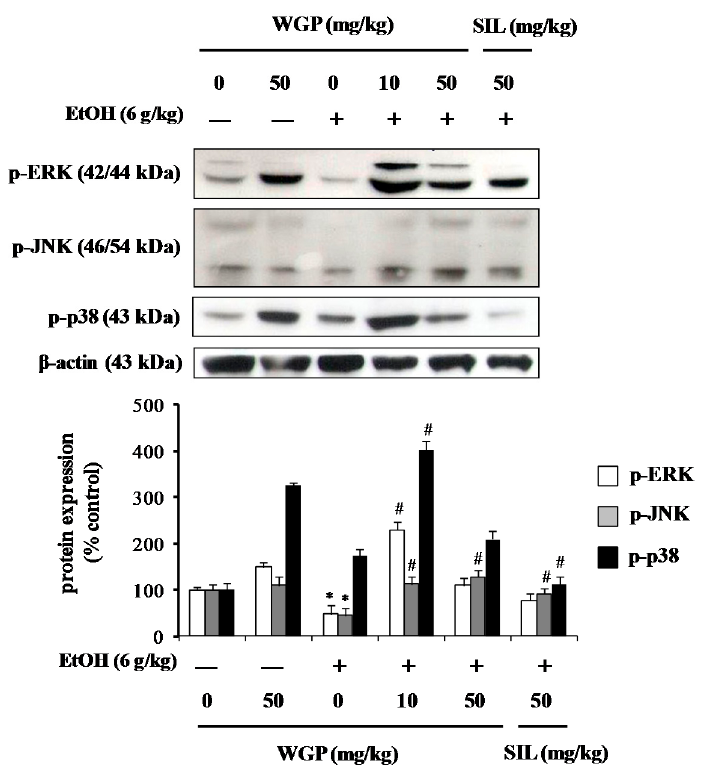
Figure 8. Effect of WGP on phosphorylation of MAP kinases in ethanol-treated SD-rats. Each value represents the mean ± S.D. for five rats. * p < 0.05 indicates differences from the unstimulated-control group; # p < 0.05 indicates differences from the ethanol-treated group.